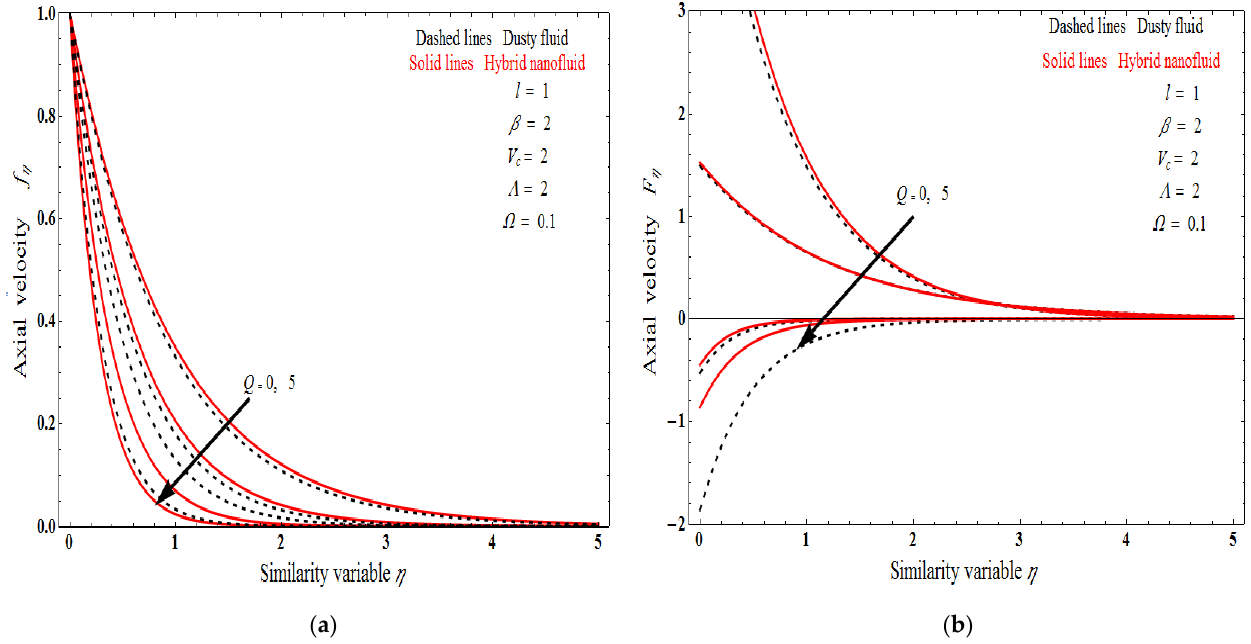
Figure 5. Influence of fluid velocity ( a ) f